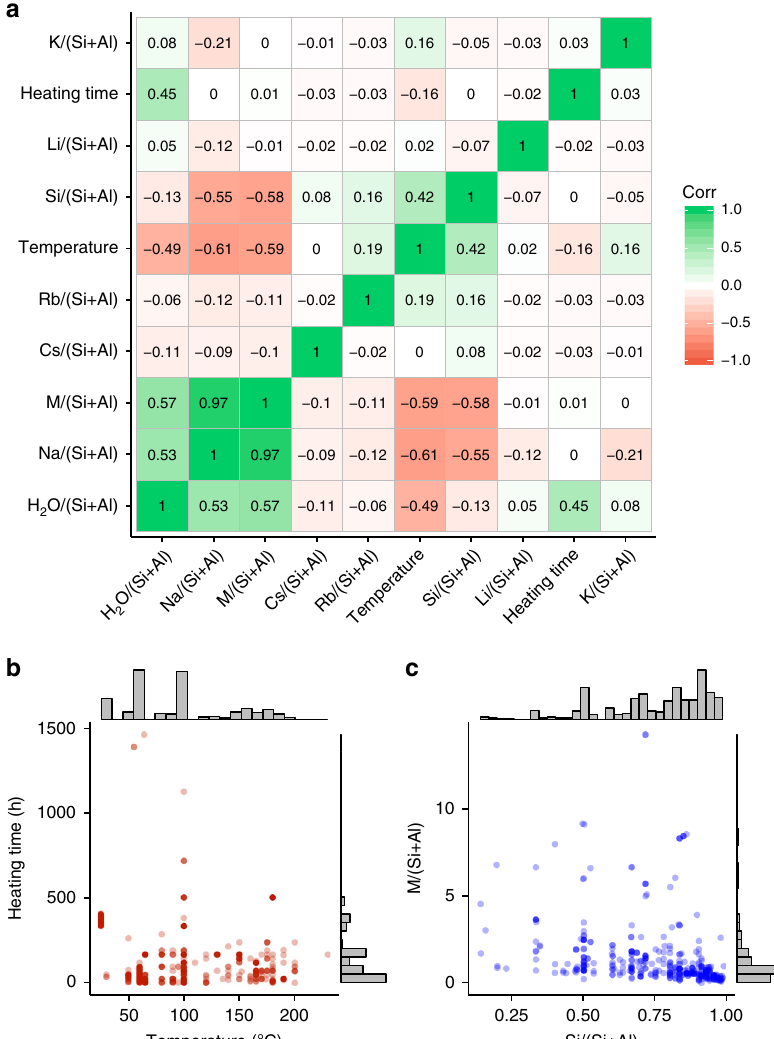
Fig. 2 Overview of the dataset. a Correlogram showing the relations between synthesis descriptors of all synthesis conditions that crystallize zeolites. Distribution of the dataset showing b heating time versus temperature and c M/(Si + Al) versus Si/(Si + Al). A total amount of cations, M/(Si + Al), is calculated with charge consideration (i.e., (M + + 0.5M 2 + )/(Si +